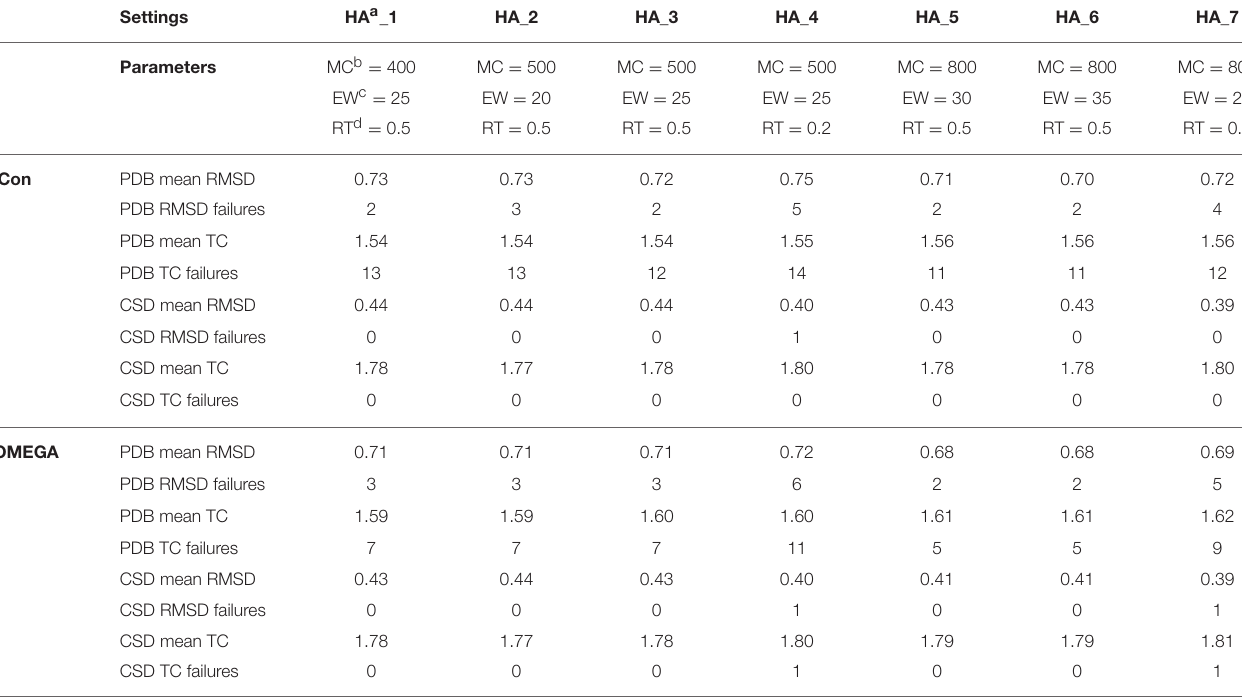
TABLE 4 | Mean RMSD and TC score values obtained for PDB and CSD data set compounds by using iCon and OMEGA with high accuracy settings.